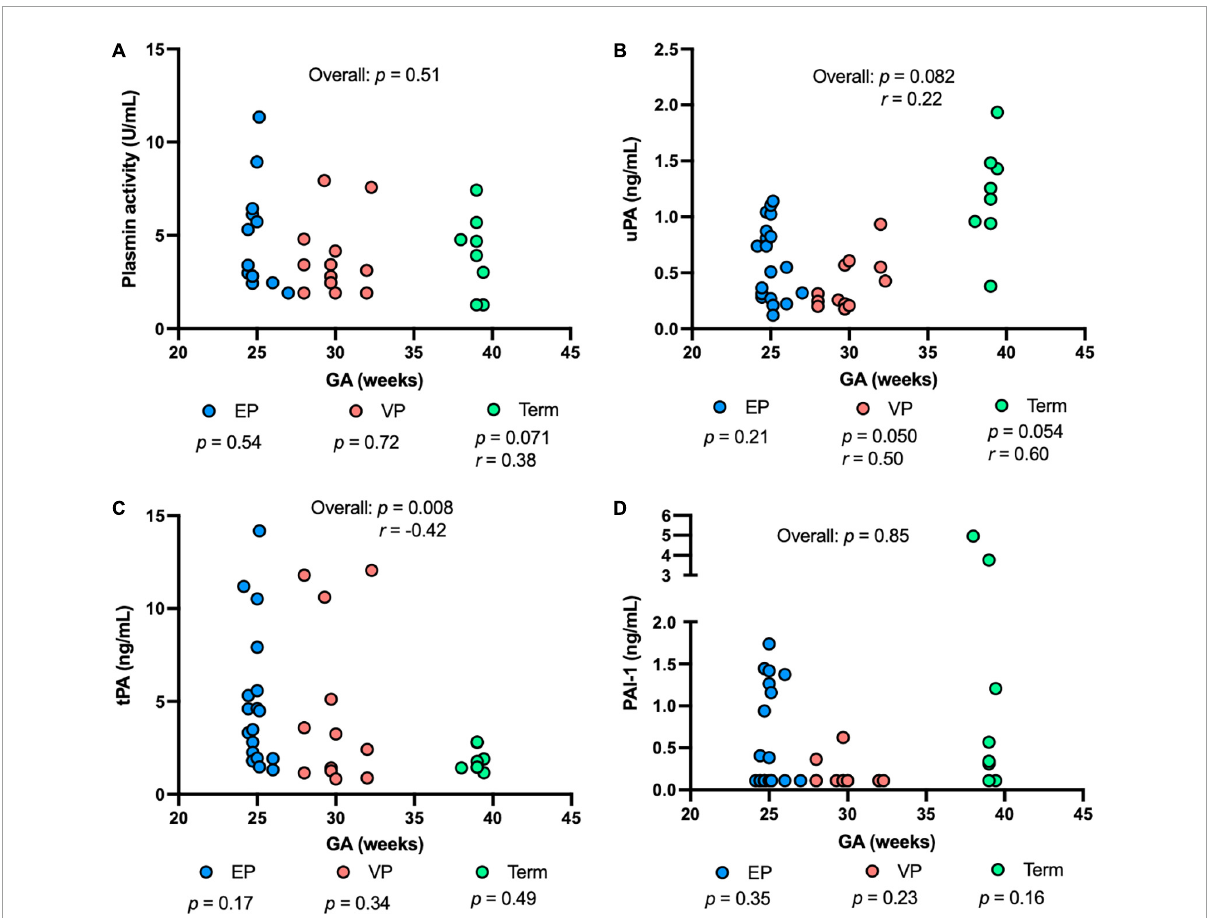
FIGURE3 The levels of plasmin system components in milk from extremely preterm-(EP), very preterm-(VP), and term-delivering mothers across gestational age (GA) at birth. (A) Plasmin activity across GA; (B) human urokinase-type plasminogen activator (uPA) across GA; (C) human tissue-type plasminogen activator (tPA) across GA; (D) human plasminogen activator inhibitor type 1 (PAI-1) across GA in human milk from EP ( n = 20), VP ( n = 12), term groups ( n = 8), and combined groups (overall, n = 40). r , Spearman